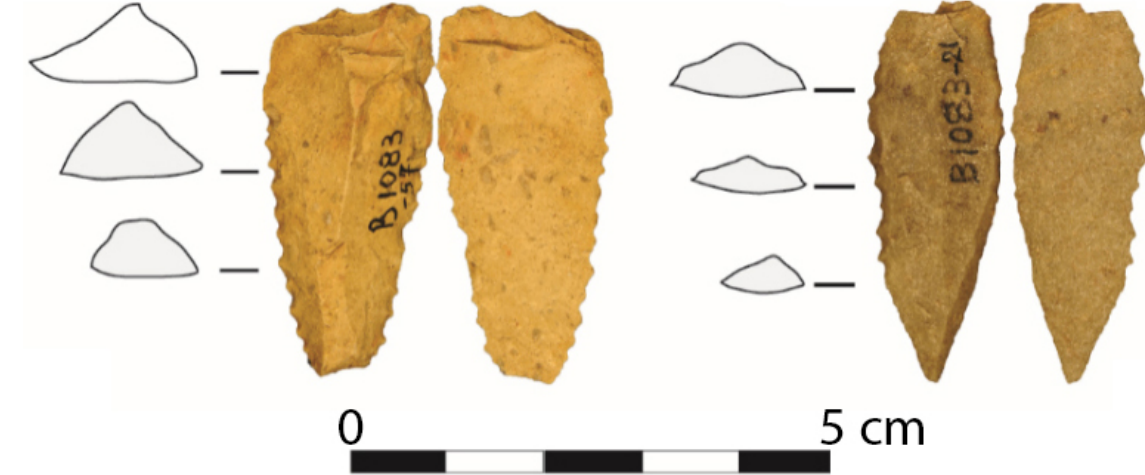
Figure 10. Serrate points made on small flakes, lacking bifacial thinning prior to pressure flaking